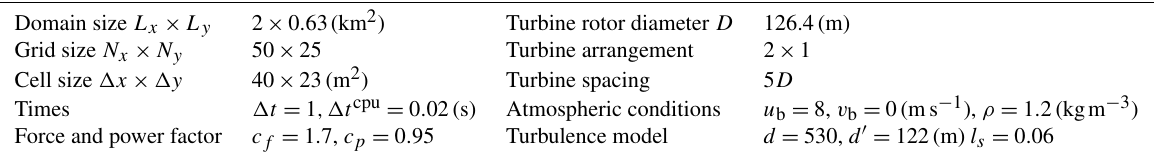
Table 2. Summary of the WFSim simulation set-up.